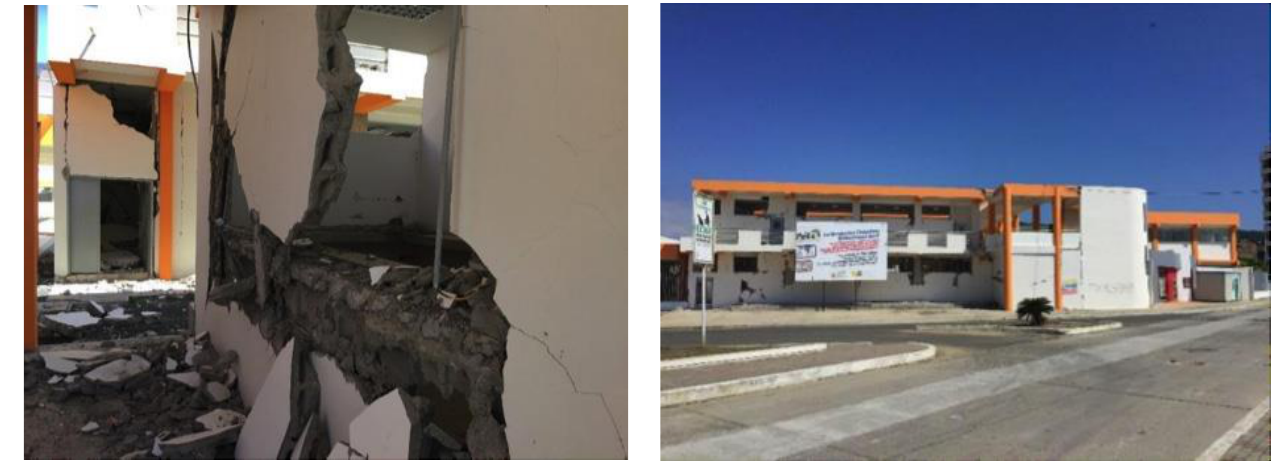
Figure 2. Collapsed school building during the earthquake of April 2016.